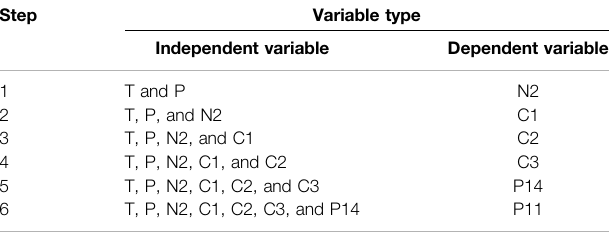
TABLE 6 | Arrangement of input and output variables of cascaded ANN architecture.